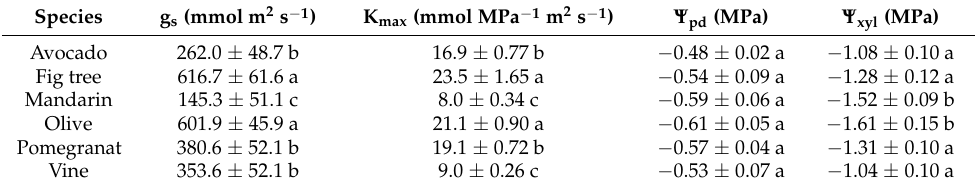
Table 2. Stomatal conductance (g s ), maximum leaf hydraulic conductance (K max ), predawn water potential ( Ψ pd ), and xylem water potential ( Ψ xyl ) of six fruit species.